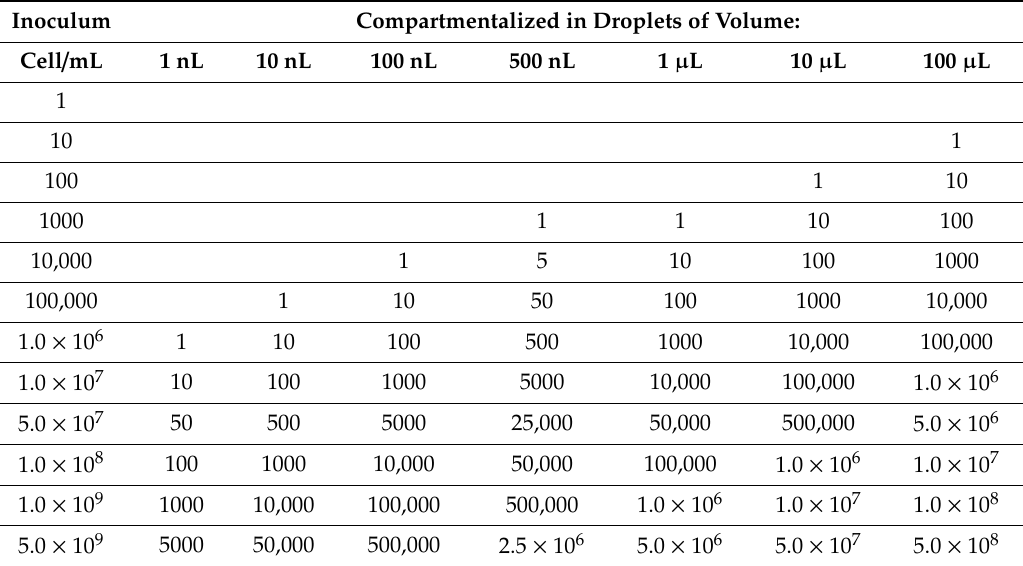
Table 1. Cell numbers per droplet in dependence on appropriate inoculum densities.